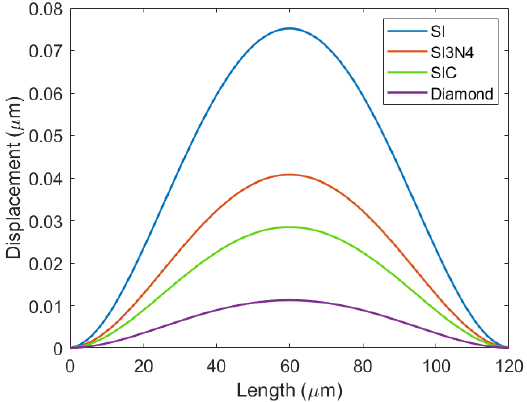
Figure 4. The membrane deflections of different